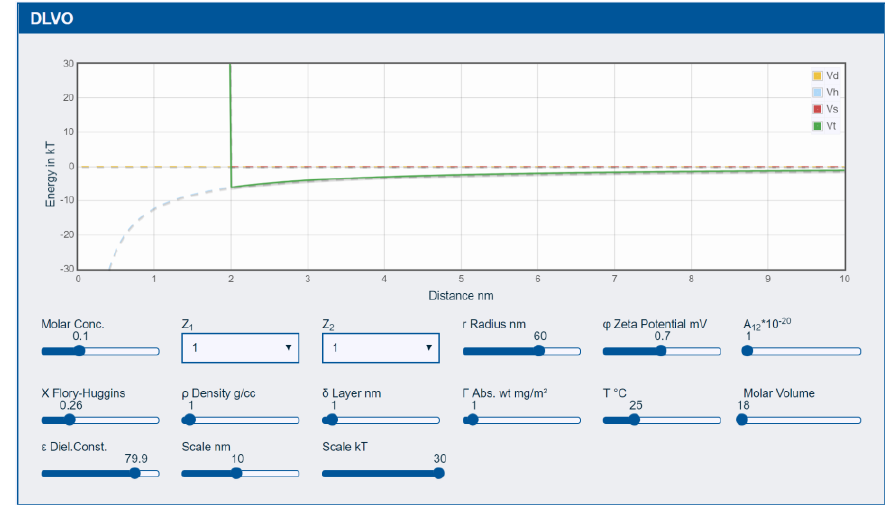
Figure 2. With charge stabilization turned off ( ϕ ≈ 0), a 1 nm layer thickness δ is enough to provide a strong barrier. Playing with most other parameters makes no difference, including the Flory–Huggins χ parameter, until this exceeds 0.5 and the system suddenly collapses.